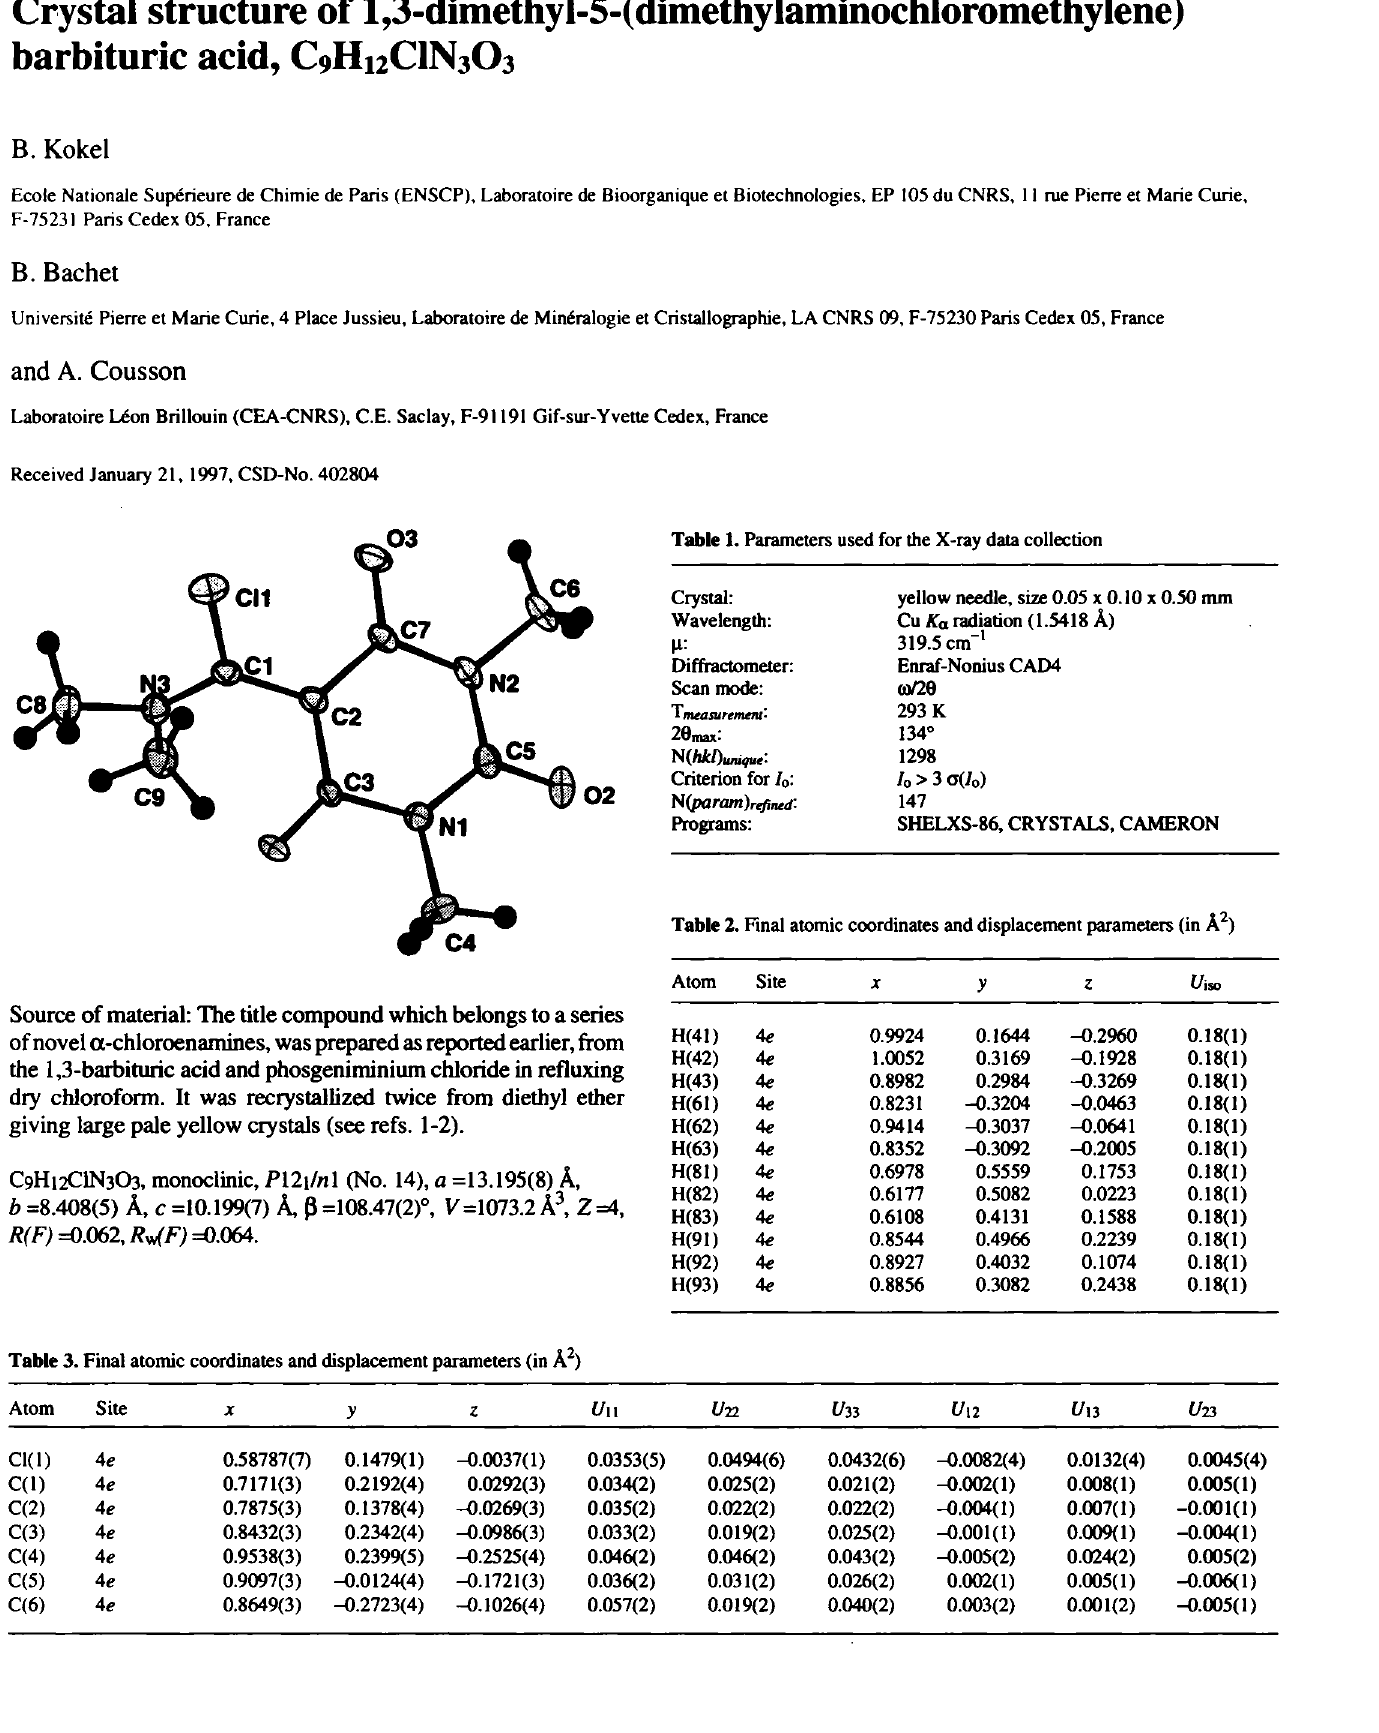
Table 1. Parameters used for the X-ray data collection